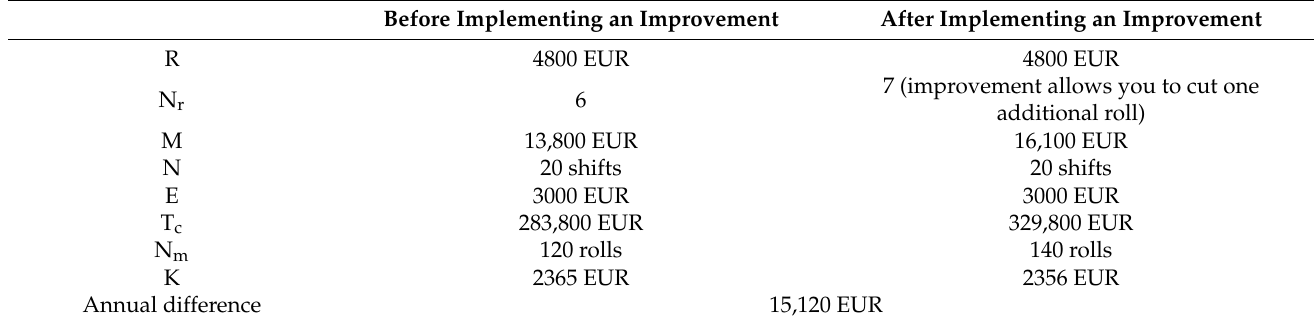
Table 3. Situation before and after the implementation of the